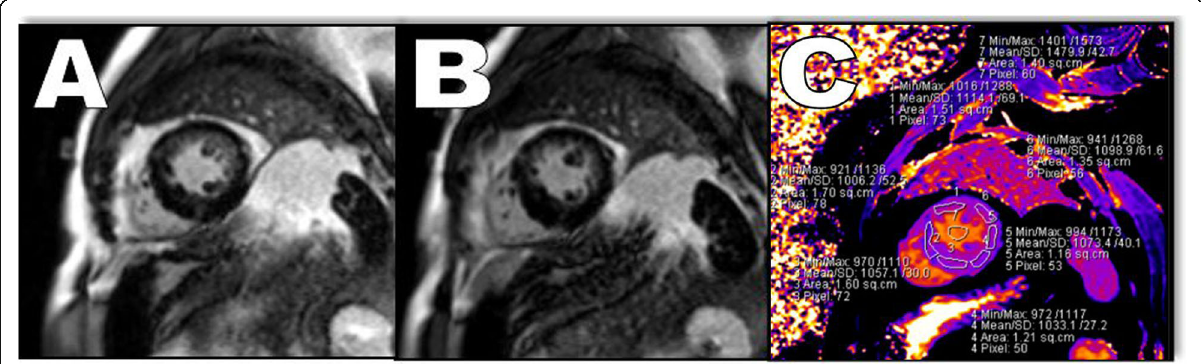
Fig. 2 a Mid-ventricular LGE image showing inferior insertion point enhancement and faint anterior and AL segment enhancement. b Mid- ventricular LGE at the same level of planned T1 mapping image showing faint focal inferior insertion point enhancement. c Native T1 mapping image planned at a different level from that showing